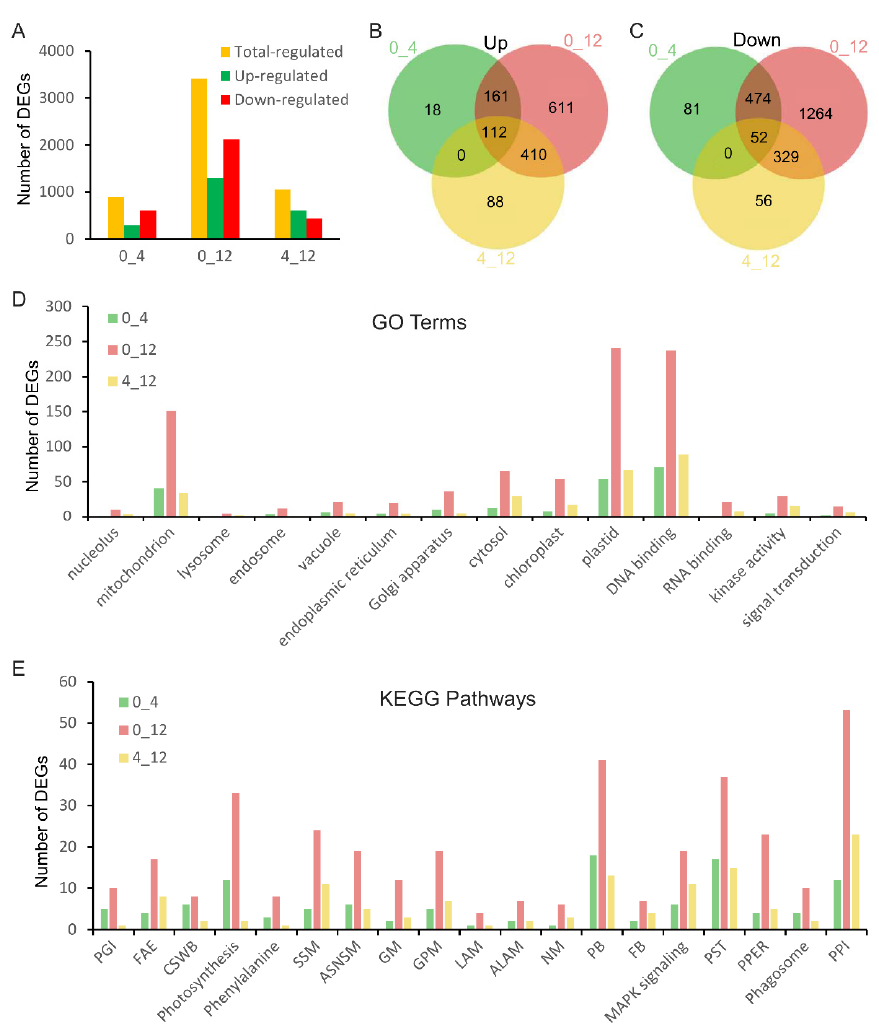
Figure 4. Transcriptome analysis of the genetic mechanism of DXWR in response to cold stress. ( A ) Differentially expressed gene statistics. ( B , C ) are Venn diagrams of up-regulated and down- regulated genes, respectively. ( D , E ) are gene ontology (GO) functional enrichment histogram and Kyoto encyclopedia of genes and genomes (KEGG) pathway enrichment histogram, respectively. 0_4, 0_12, and 4_12 represent the comparison of DXWR seedling treatment at 4 ◦ C for 0 h and 4 h, 0 h and 12 h, and 4 h and 12 h, respectively. PGI, FAE, CSWB, SSM, ASNSM, GM, GPM, LAM, ALAM, NM, PB, FB, PST, PPER, and PPI in subfigure ( E ) represent pentose and glucuronate interconversions, fatty acid elongation, cutin suberine and wax biosynthesis, starch and sucrose metabolism, amino sugar and nucleotide sugar metabolism, glycerolipid metabolism, gycerophospholipid metabolism, linoleic acid metabolism, alpha-linolenic acid metabolism, nitrogen metabolism, phenylpropanoid biosynthesis, flavonoid biosynthesis, plant hormone signal transduction, protein processing in endoplasmic reticulum, and plant–pathogen interaction,